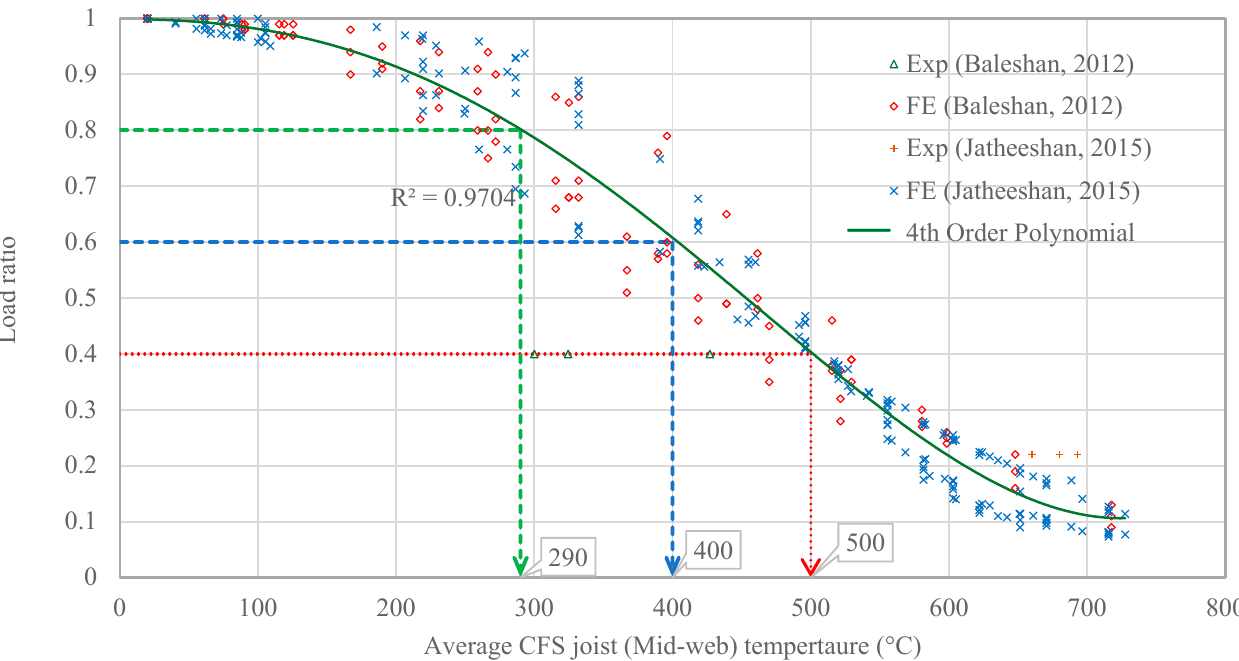
Figure 2. LR versus critical steel temperature of channel section joists at the structural failure of LSF floors [3,21]. Table 1. Critical average temperatures for structural fire failure of channel section joists at different